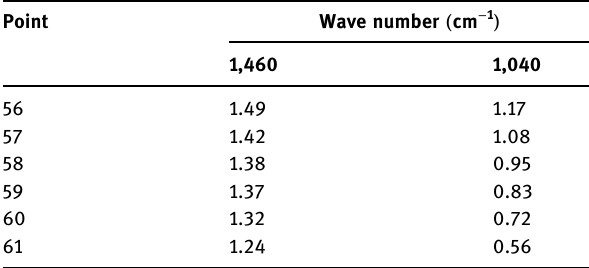
Table 2: IR relative intensity values of functional groups of MTC phenolic epoxy fi bers